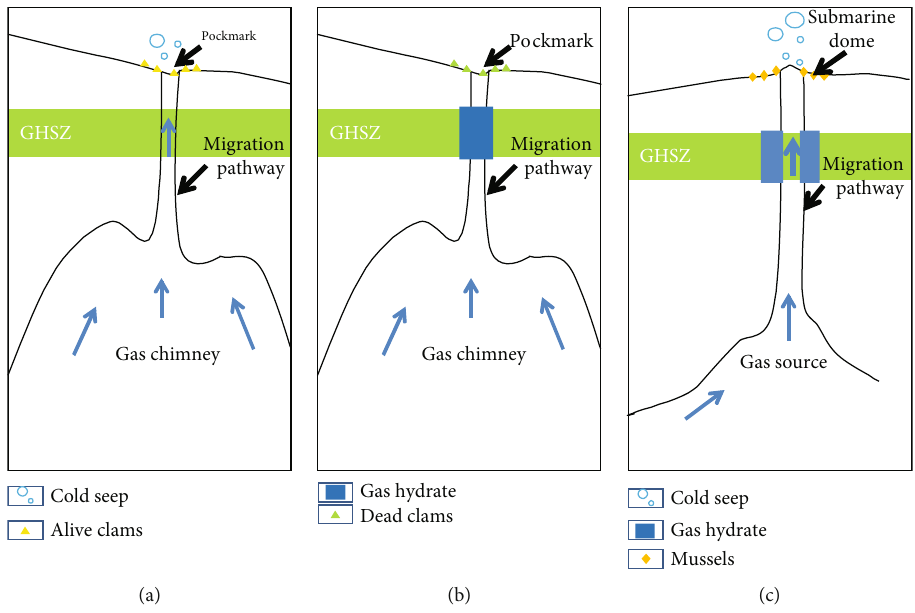
Figure 9: Cold seep evolution in the study area. (a) Fluids from the deep seabed move upward though the fl uid migration pathways, generating a cold seep ecosystem with clams as the dominant population and a pockmark on the sea fl oor. (b) Gas hydrate gradually forms to obstruct the fl uid migration pathway, causing the cold seep ecosystem to collapse gradually and kill creatures such as clams. (c) When the fl ow rate of seepage is su ffi ciently high, gas hydrates form around the fl uid migration pathways instead of inside them due to the strong submarine fl uid activity, and a submarine dome and the cold seep ecosystem with mussels as the dominant species are created in this